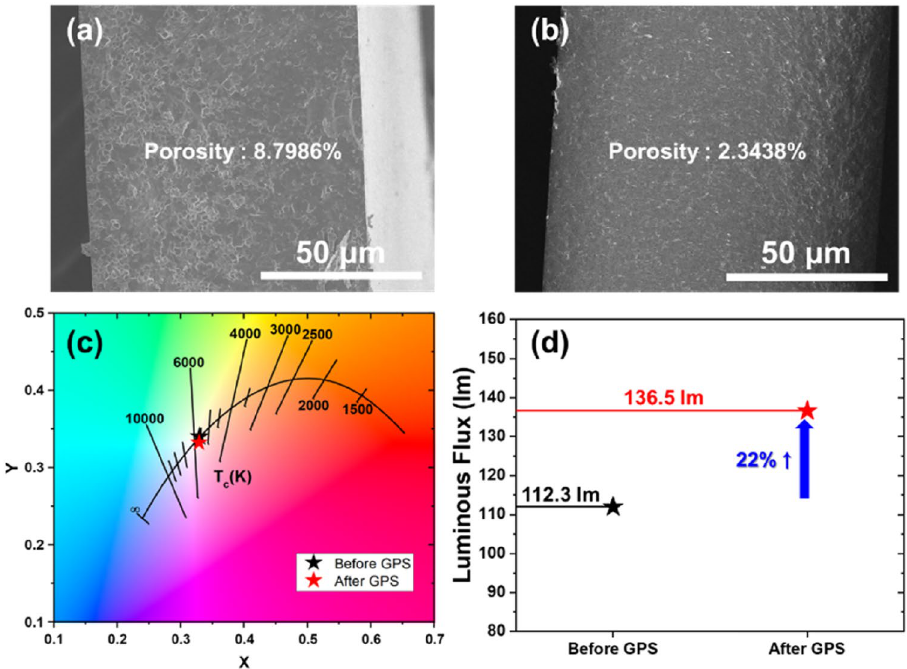
Figure 7. ( a , b ) Cross-sectional SEM images of the CPs with and without GPS post-processing, respectively, and ( c , d ) their optical properties before and after GPS.